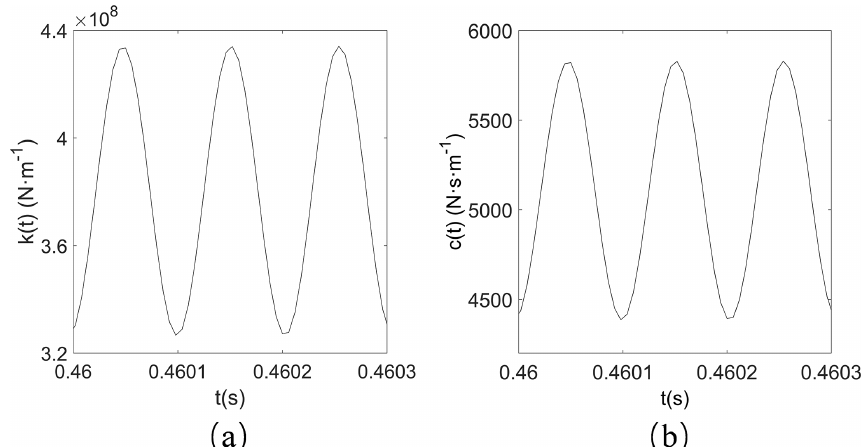
Figure 2. Meshing stiffness and damping: (a) meshing stiffness; (b) meshing